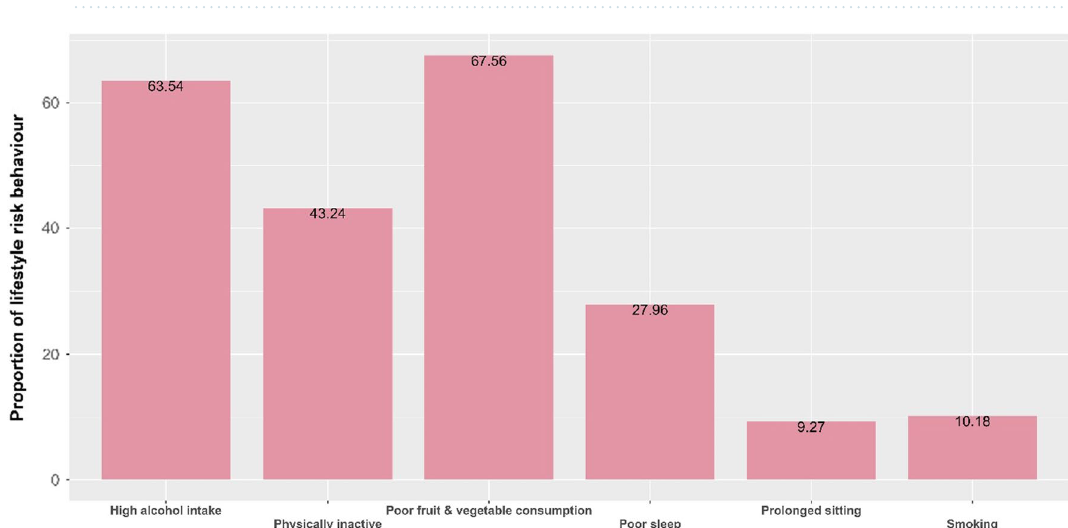
Figure 2. Lifestyle risk behaviour among UK adults with CVD data.